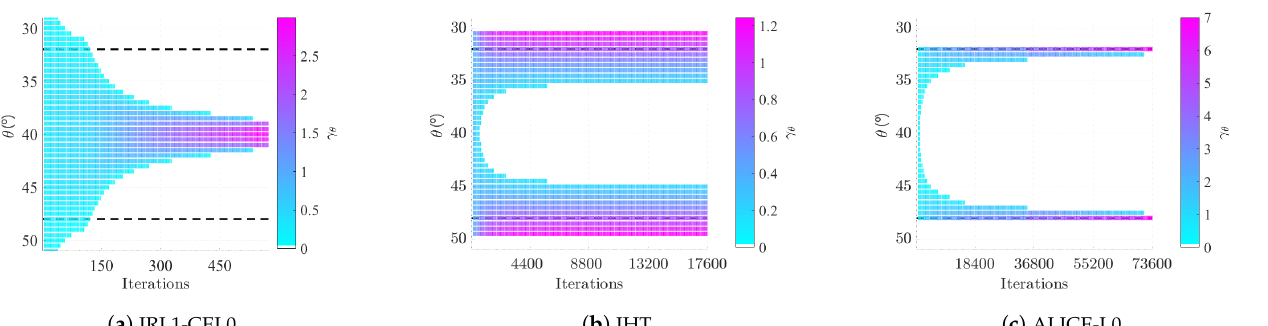
Figure 3. Solutions as iterations go by for close sources with no noise, for λ = 0.78. X-axis: iteration number. Y-axis: directions associated with components of ˆ γ . The color represents the level of the components. True sources ˜ θ 1 = 32° and ˜ θ = 48° are indicated by the black doted lines. Corresponding components of the optimal solution are equal to 7, all others 2 are